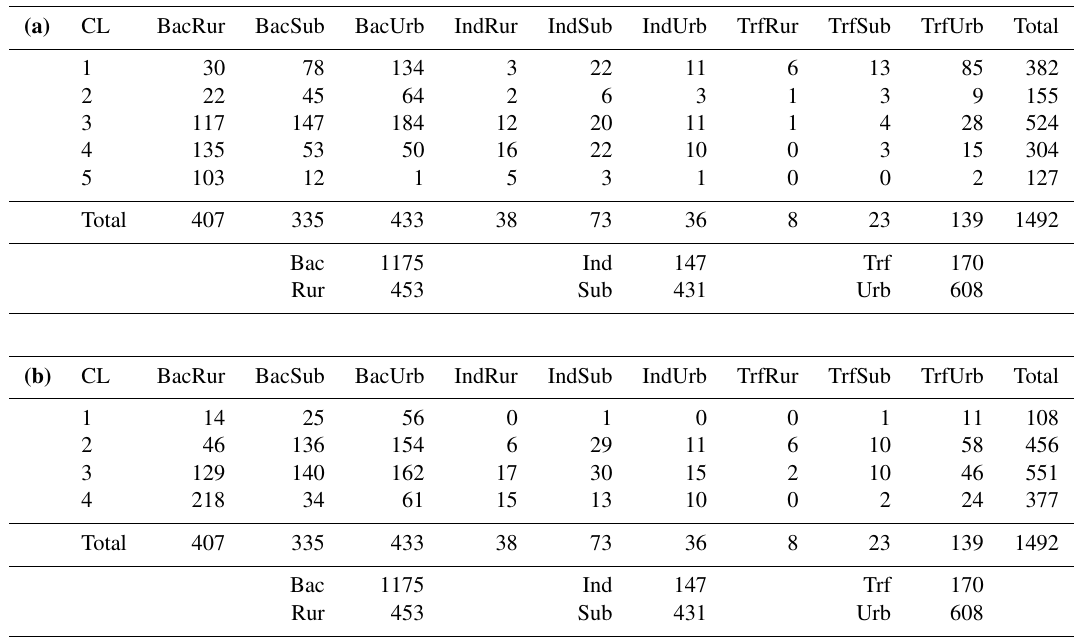
Table 1. (a) Contingency table, showing the distribution of stations in clusters (rows) vs. Airbase classification groups (columns); first CA. Abbreviations: Bac – background, Ind – industrial, Trf – traffic, Rur – rural, Sub – suburban, Urb – urban. (b) Same as (a) but for the second CA.